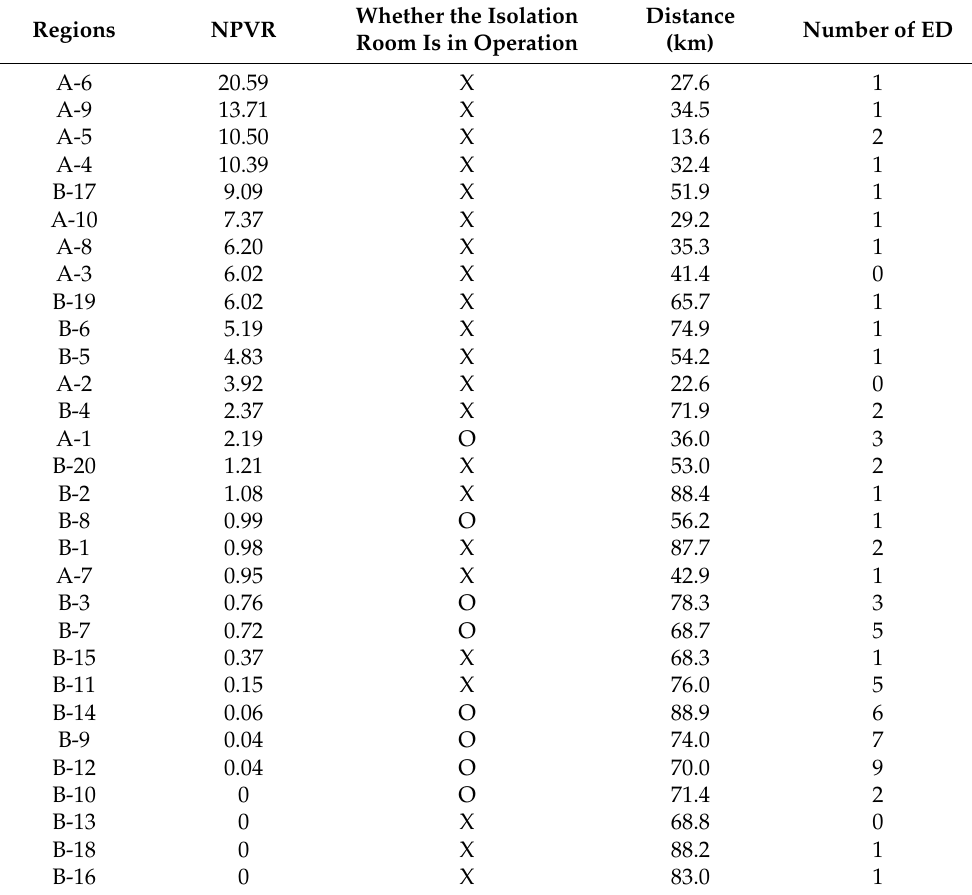
regions outside the Daegu Metropolitan